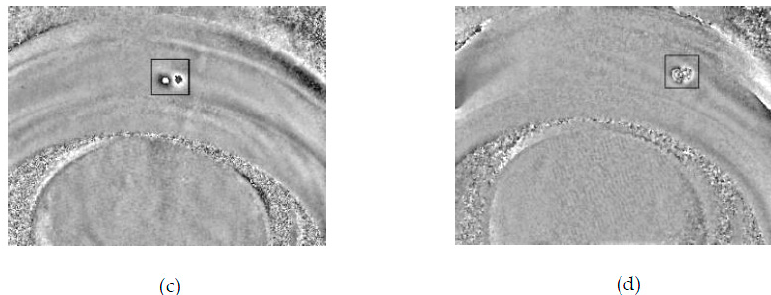
Figure 2. Shearography images of tires, where ( a , b ) portray bubble defects present in the shearography images of the tire treads, and ( c , d ) illustrate bubble defects present in the shearography images of the tire sidewalls.